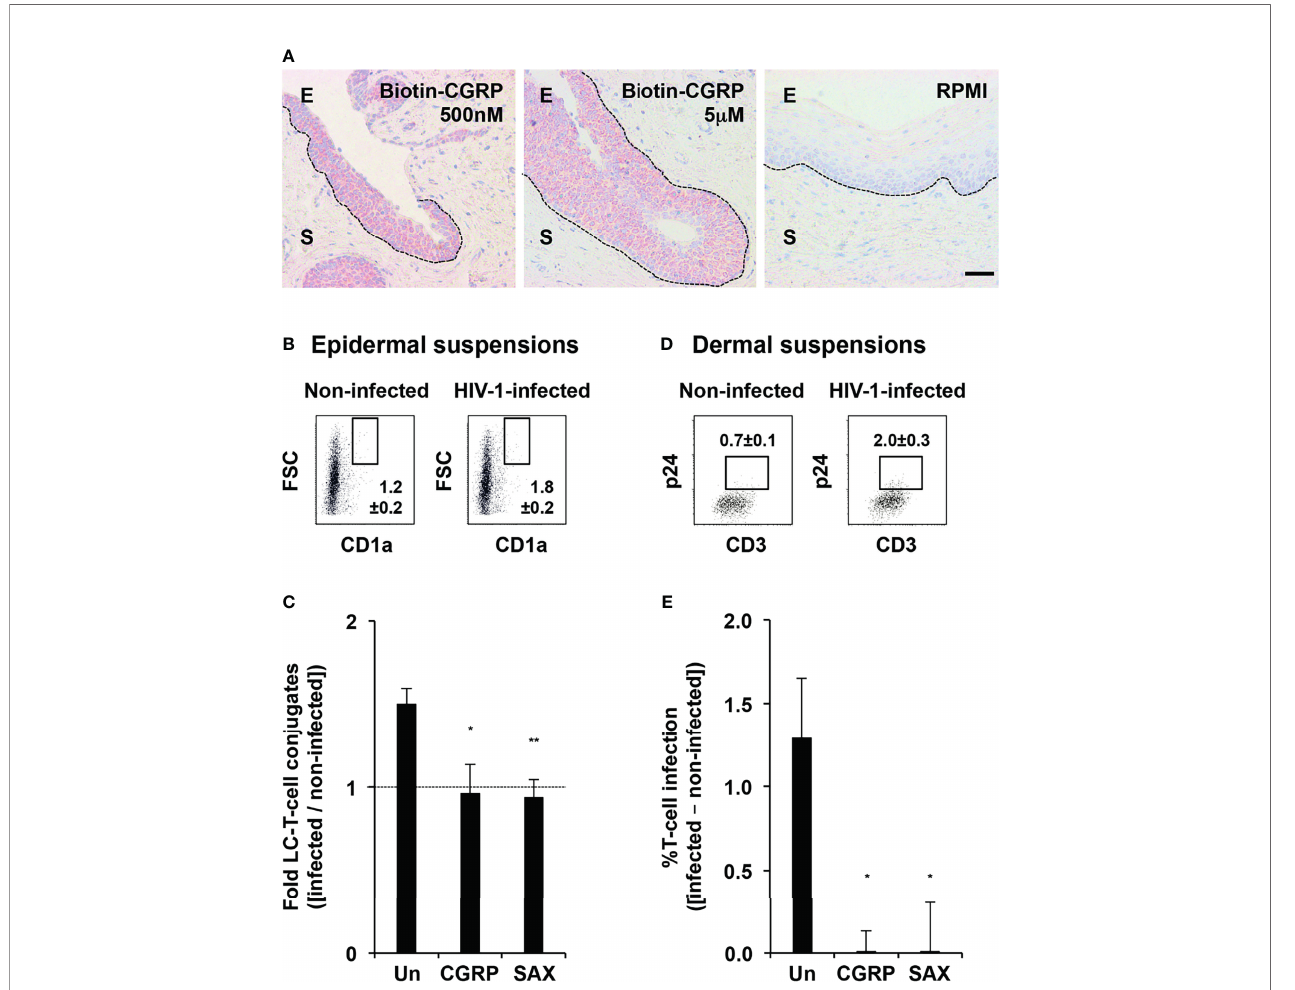
FIGURE 6 | CGRP and SAX inhibit mucosal HIV-1 transmission in human mucosal tissues ex-vivo . (A) Entry of biotinylated CGRP into the epithelium of penile fossa navicularis explants, revealed with streptavidin-HRP, AEC peroxidase substrate (red), and hematoxyline counterstaining (blue). Images are representative of n = 3 tissues; broken lines denote the basement membranes and scale bar = 20 m m; E, epithelium and S, stroma. (B, C) Inner foreskin tissue explants were left untreated or pre-treated with CGRP or SAX (1 m M) for 24 h at 37°C. Explants were next inoculated in a polarized manner with either non-infected or HIV-1-infected PBMCs for 4 h, and immediately digested with dispase/trypsin. In panel (B) , shown are representative fl ow cytometry dot plots of epidermal cell suspensions triple stained for surface expression of CD3, CD8, and CD1a and examined by fl ow cytometry. Cells were gated on CD3+CD8- T-cells, and numbers represent mean ± SEM (of n = 4 independent experiments using tissues from different individuals) percentages of FSC high CD1a high conjugates following inoculation with either non-infected or HIV- 1-infected PBMCs. In panel (C) , graph shows mean ± SEM folds increase in conjugate percentages, calculated as [(% conjugates following inoculation with HIV-1- infected PBMCs)/(% conjugates following inoculation with non-infected PBMCs)]. *p = 0.0252 and **p = 0.0071 for CGRP or SAX vs. untreated, two-sided Student ’ s t-test. (D, E) Other explants were further incubated for additional three days and digested with collagenase/DNase. In panel (D) , shown are representative fl ow cytometry dot plots of dermal cell suspensions double stained for surface CD3 and intracellular p24 and examined by fl ow cytometry. Cells were gated on FSC low SSC low lymphocytes, and numbers represent mean ± SEM (n = 4) percentages of CD3+p24+ cells following inoculation with either non-infected or HIV-1- infected PBMCs. In panel (E) , graph shows mean ± SEM percentages of HIV-1-infected T-cells, calculated as [(%CD3+p24+ cells following inoculation with HIV-1- infected PBMCs) − (%CD3+p24+ cells following inoculation with non-infected PBMCs)]; *p = 0.0249 and 0.0209 for CGRP or SAX vs. untreated, two-sided Student ’ s